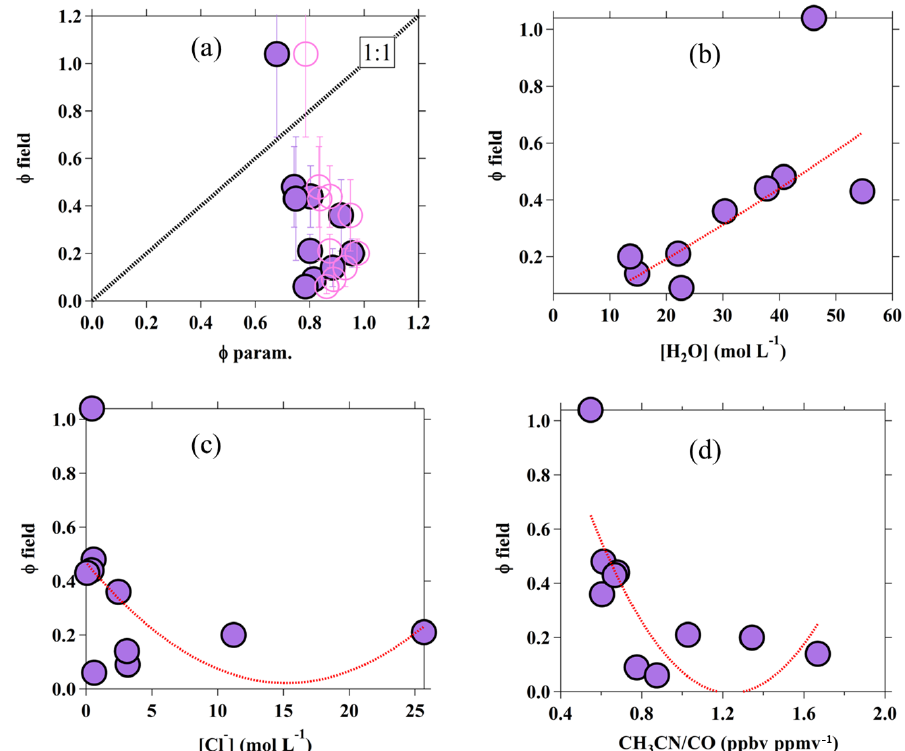
Figure 7. Scatter plots for (a) yield derived from the field versus yield calculated from the parameterization, using k R4 /k R3 of 483 (recom- mended by Bertram and Thornton, 2009; solid circle) and 836 (recommended by Behnke et al., 1997; pink open circle). Error bars represent the uncertainty in field-derived φ , and the black dotted line represents the 1 : 1 ratio; (b) field-derived yield versus aerosol water content; (c) field-derived yield versus chloride; and (d) field-derived yield versus CH 3 CN / CO. The red dotted lines show the quadratic fitting line of the